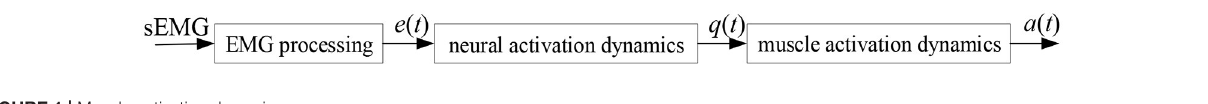
FIGURE 1 | Muscle activation